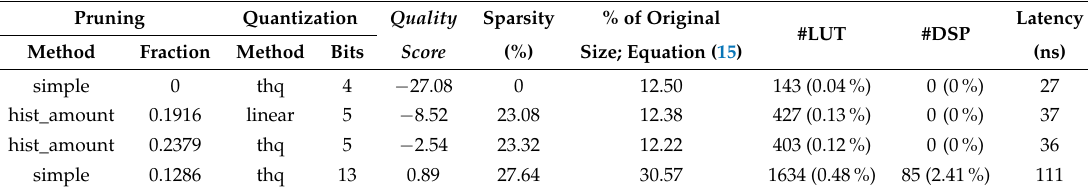
Table 1. [IAP] Results for pruned and quantized model. Percentages in the ‘#LUT’ and ‘#DSP’ refer to the overall resources available on the